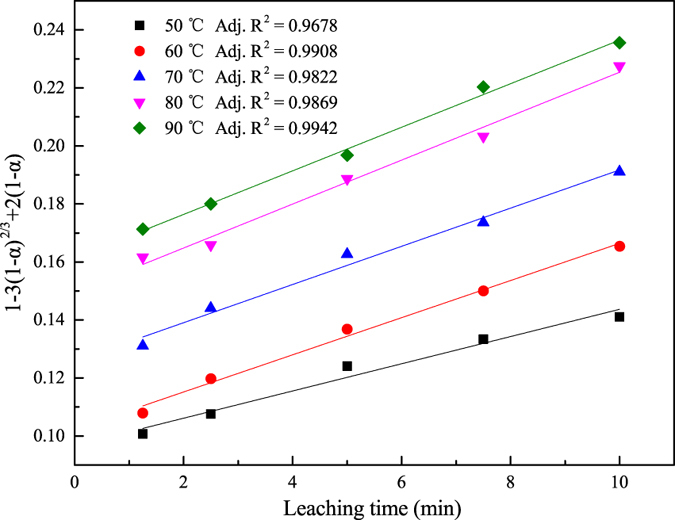
Plots of [1 − 3(1 − α)2/3 + 2(1 − α)] versus time at various leaching temperatures for 60 min, for activated waste phosphors.